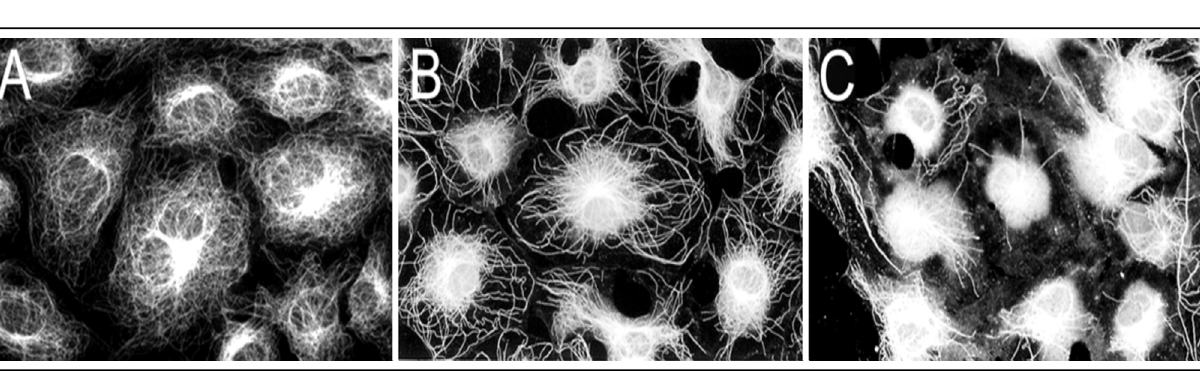
Figure 1. As 3+ induced disassembly of MTs in RFL6 cells. Growth-arrested RFL6 cells on coverslips were treated without or with As 3+ at indicated concentrations for 24 h, and then immunofluorescently stained for visualization of MTs. ( A ) control; ( B ) 5 µM As 3+ ; ( C ) 20 µM As 3+